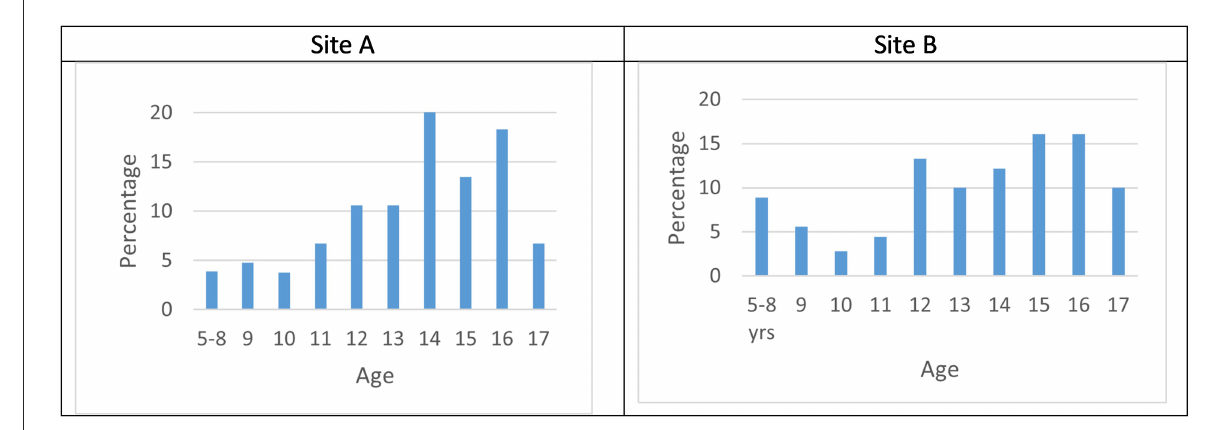
FIGURE1 (A,B) Age at referral.